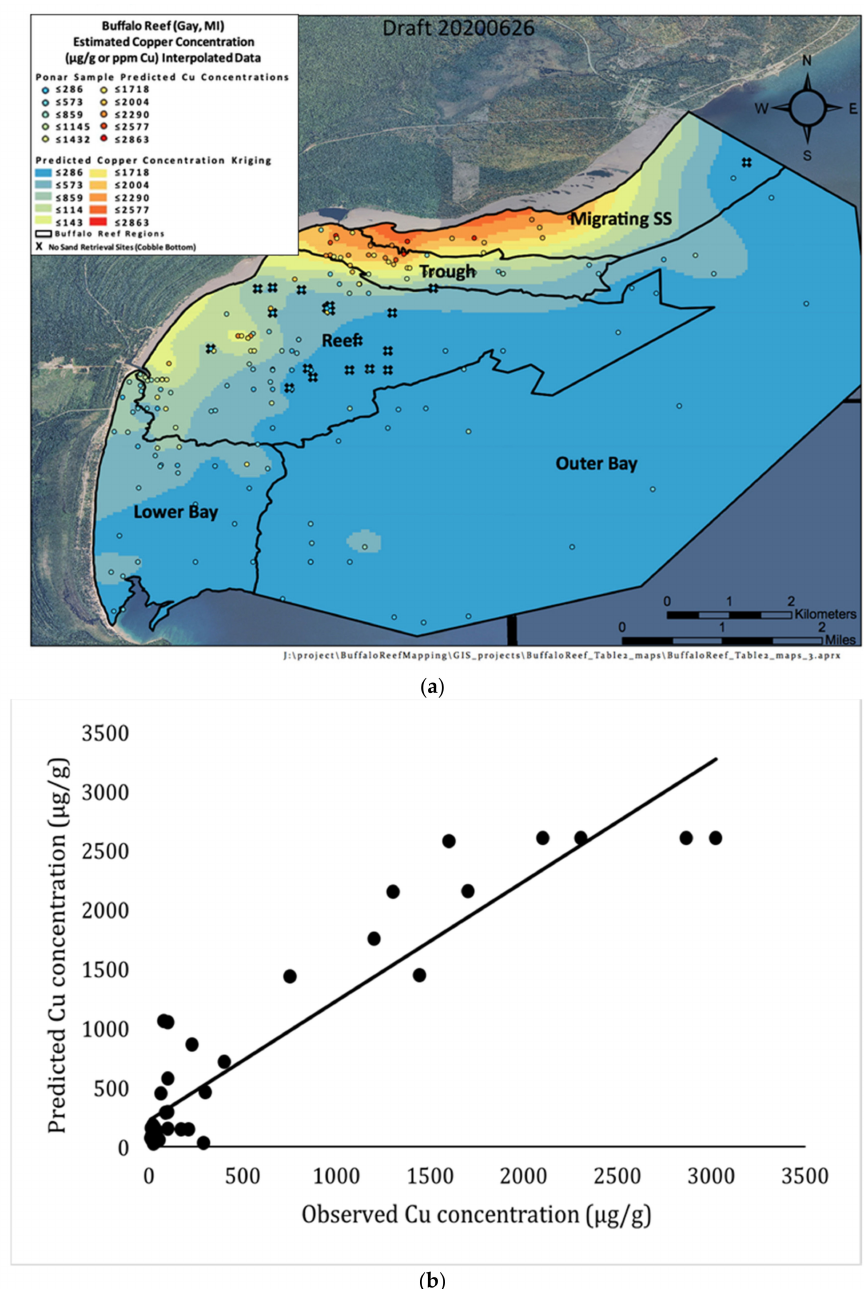
Figure 11. Copper concentrations contoured across Grand (Big) Traverse Bay and the regression of predicted versus observed Cu concentrations. ( a ) Cu concentration contours closely resemble patterns for %SS on Buffalo Reef, in that values are highest along a shoreline strip from the Gay Pile to the Coal Dock, moderate around the Traverse River Seawall, and much lower in the lower and outer bays. Concentrations also decline more around the outer edges of Buffalo Reef. ( b ) Regression of observed ( x -axis) versus predicted ( y -axis) copper concentrations. “Predicted” values come from % SS calculations, whereas “observed” values are directly assayed. The black line is a fit linear regression. Note that the positive intercept suggests that predicted values are slightly higher than observed values, especially when concentrations are